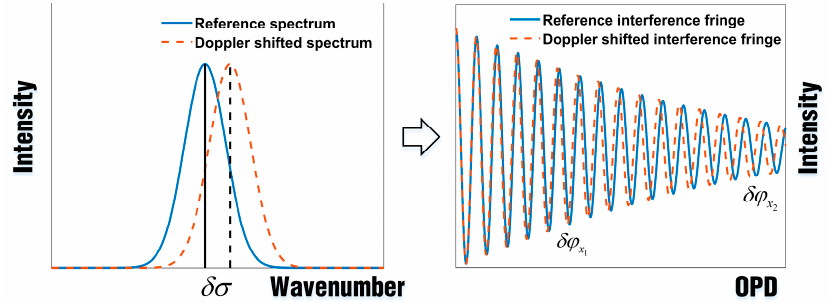
Figure 1. Schematic diagram of the Doppler shift of the emission line and the interferogram fre- quency change.